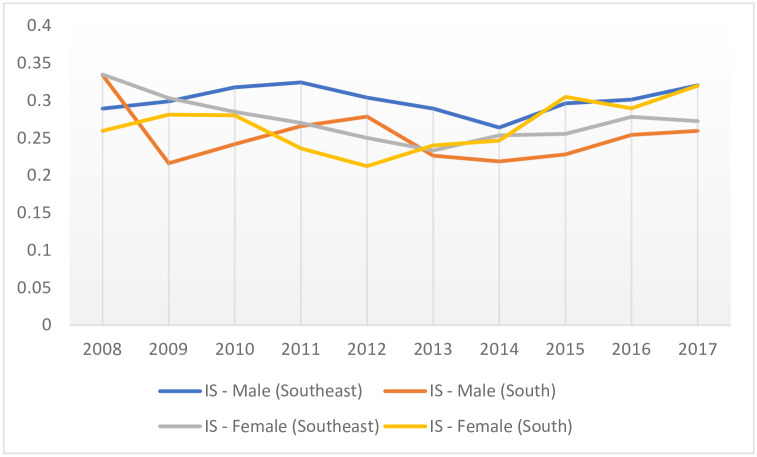
Temporal trend of the mortality (x100,000 inhabitants) due to ischemic stroke, stratified by gender of young adults, residents of developed regions of Brazil, 2008–2017.IS—Ischemic Stroke; x-axis: years; y-axis: mortality rates.